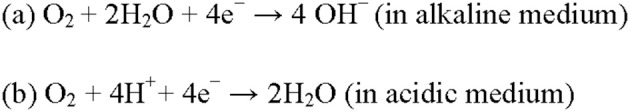
The four-electron ORR process in (a) alkaline and (b) acidic medium.